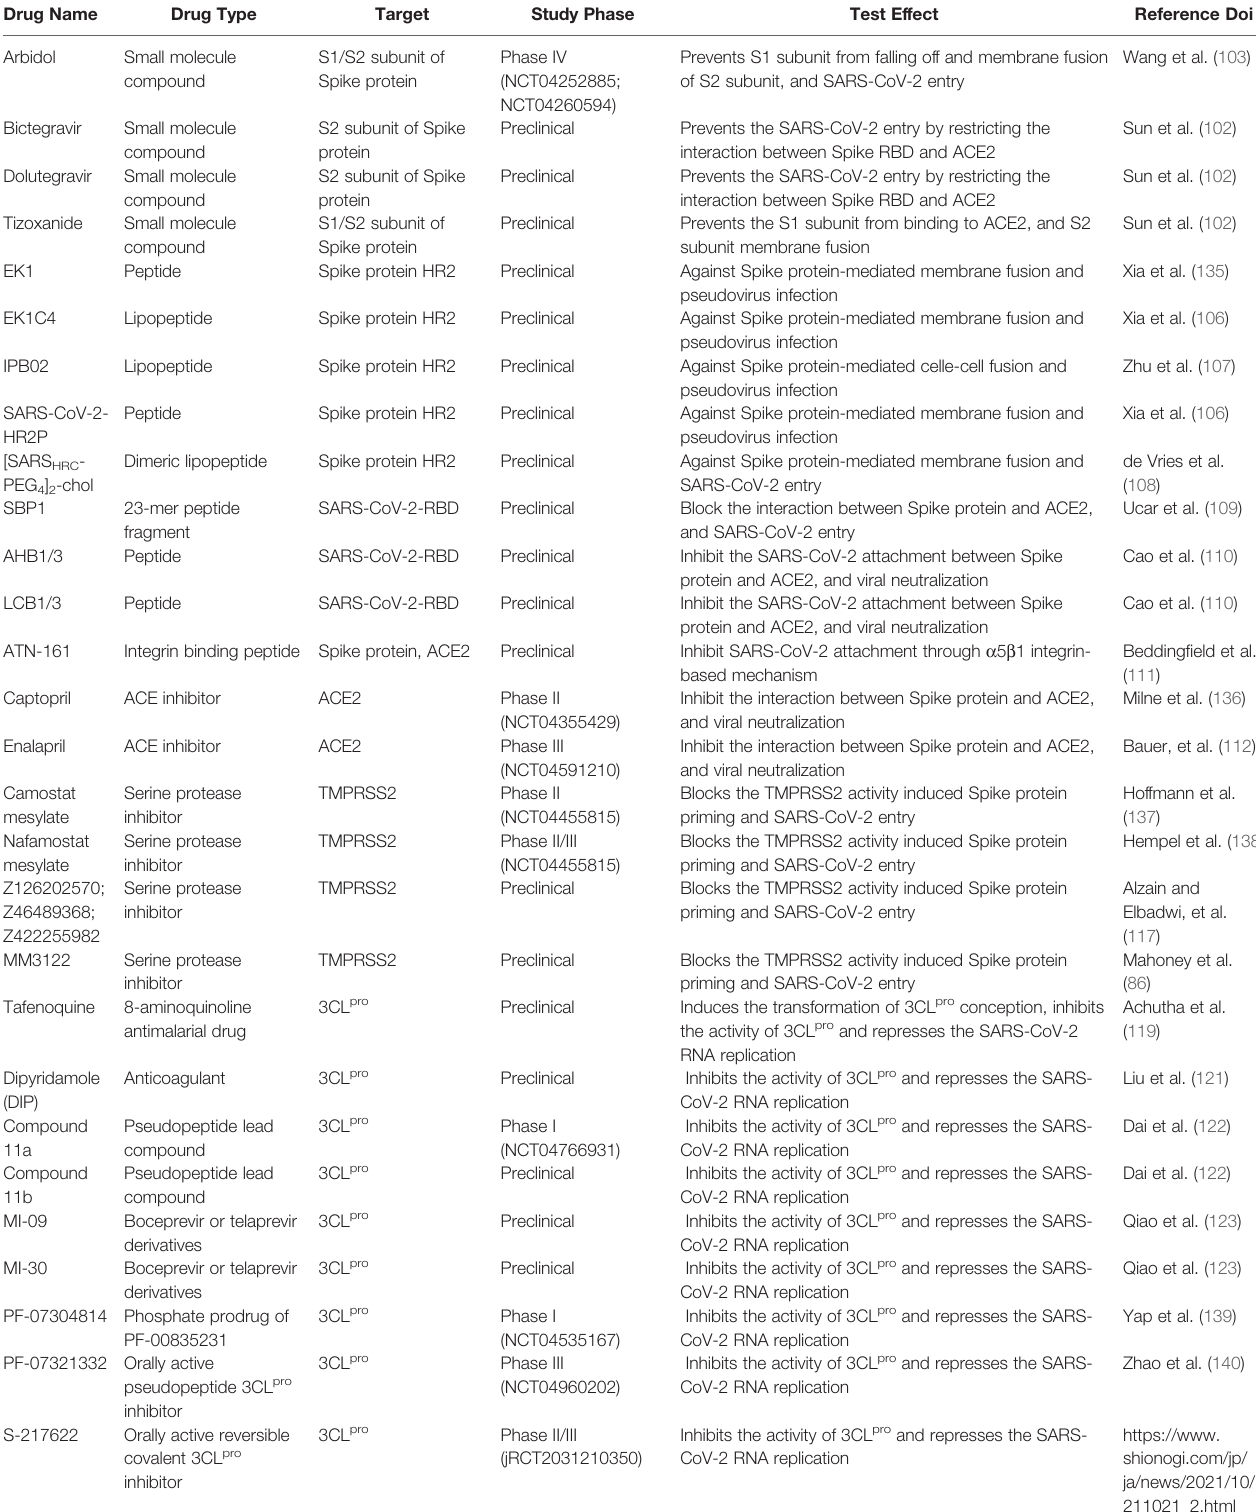
TABLE 2 | List of drugs that may be effective in the preclinical and clinical phases for COVID-19. Drug